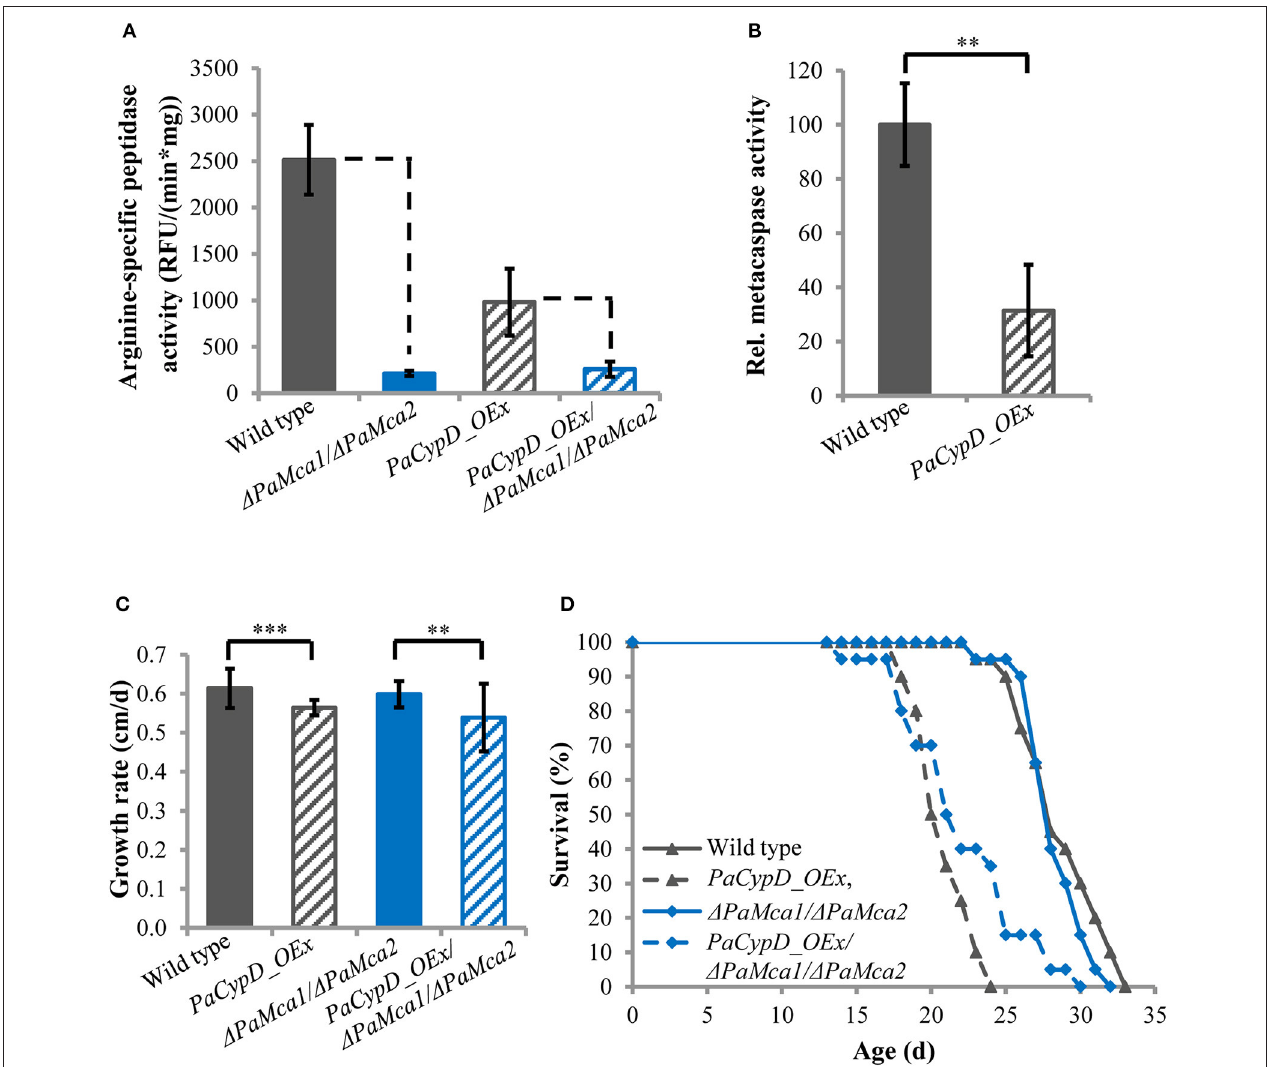
FIGURE 1 | (A) Arginine-specific peptidase activity [relative fluorescence units (RFU)/(min*mg)] in total protein extracts of mycelium of 11 d old wild type, PaCypD_OEx and the different deletion strains. As substrate, the fluorochrome-coupled peptide Z-GGR-Amc was used. Fifty micrograms total protein extracts of four different isolates of each strain were measured. (B) Relative metacaspase activity was determined as difference of the arginine-specific peptidase activity from Panel A between wild type and ∆ PaMca1/ ∆ PaMca2 or PaCypD_OEx and PaCypD_OEx/ ∆ PaMca1/ ∆ PaMca2 . The mean metacaspase activity of the wild type was set to 100%. (C) Growth rate and (D) lifespan of 20 different isolates of the wild type, PaCypD_OEx , ∆ PaMca1/ ∆ PaMca2, and the triple mutant PaCypD_OEx/ ∆ PaMca1/ ∆ PaMca2 on M2 medium. Data represent average ± SEM (2-tailed student’s t -test), ** P < 0.01, *** P < 0.001.